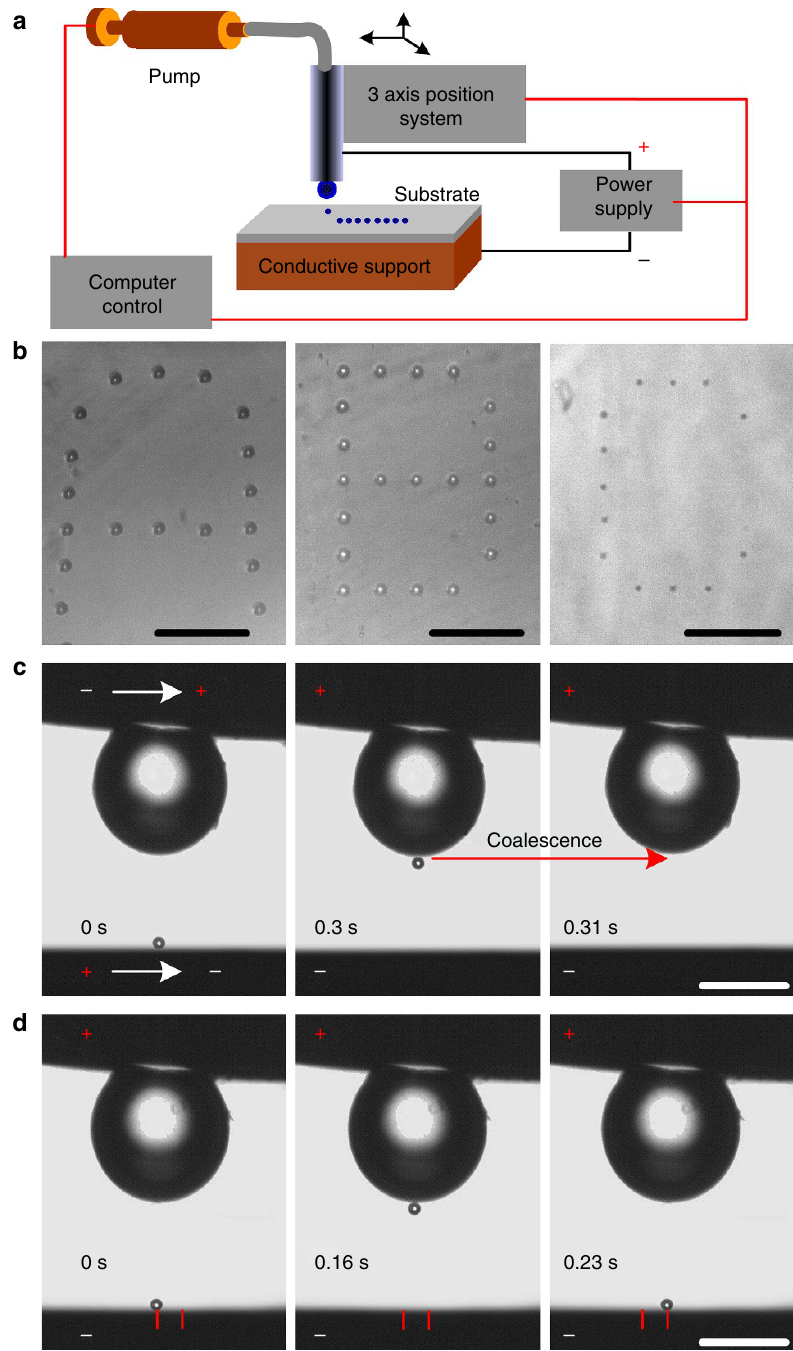
Figure 3 | Electric field aided hydrodynamically dispensing and manipulation of small droplets. ( a ) Schematic representation of the experimental set-up. ( b ) Characters ‘written’ by dispensing small droplets on the surface. The characters ‘A’ and ‘B’ were written with an orifice with diameter of 180 m m, ‘C’ was written with an orifice of 40 m m. The average droplet radii for characters ‘A’, ‘B’ and ‘C’ are about 15, 7 and 2 m m, respectively. Scale bars for ‘A’, ‘B’, and ‘C’, 200, 100 and 50 m m, respectively. ( c ) Merging of a dispensed droplet with the mother droplet. ( d ) Bouncing and horizontal movement of the dispensed droplets under the action of Coulomb force. Scale bars in c and d , 200 m